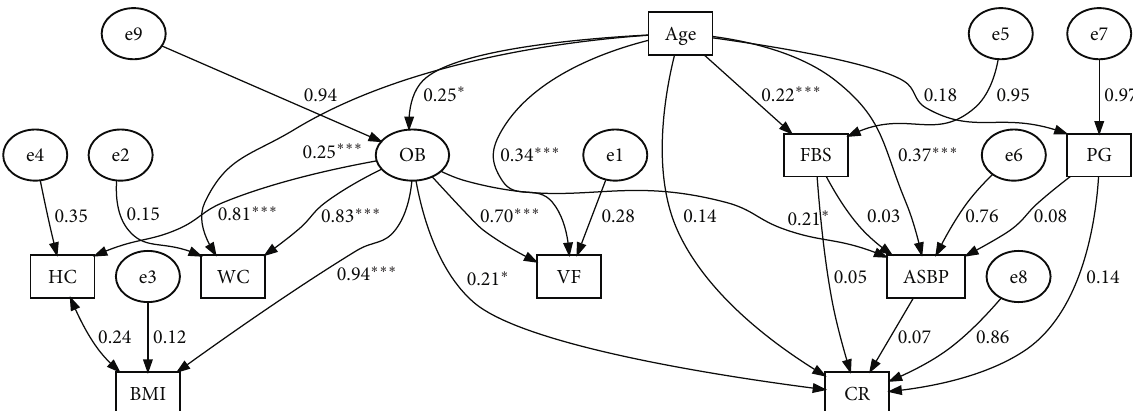
Figure 7: Structural equation modelling assessing the effect of type 2 diabetes on manifest blood pressure (average systolic blood pressure) and coronary risk (Model